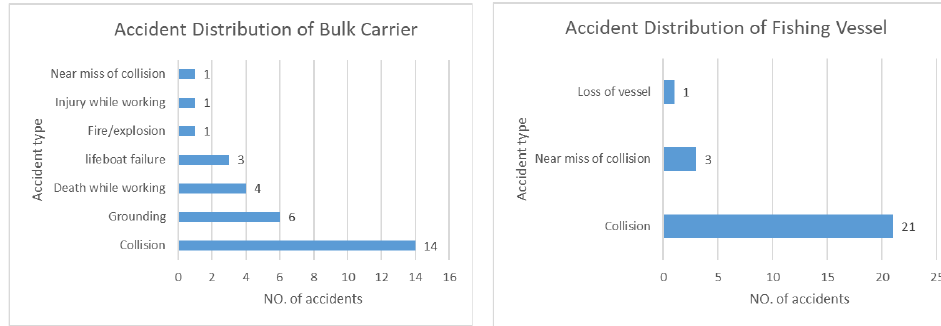
Figure 9. Accident distribution of container ships ( left ) and tankers ( right ).